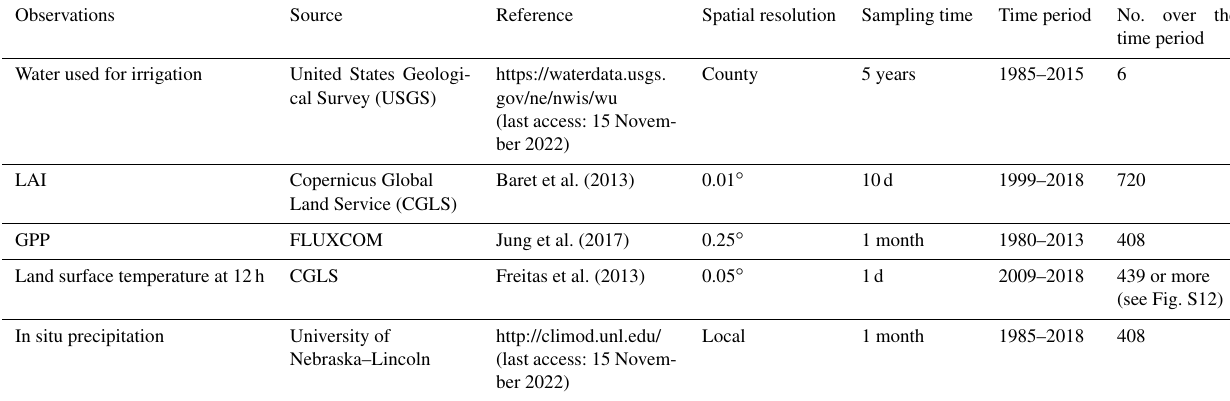
Table 3. Evaluation